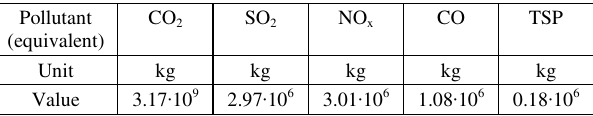
Table 7. Total potential emission of pollutants associated with charging the batteries of one million EVs in Poland Pollutant